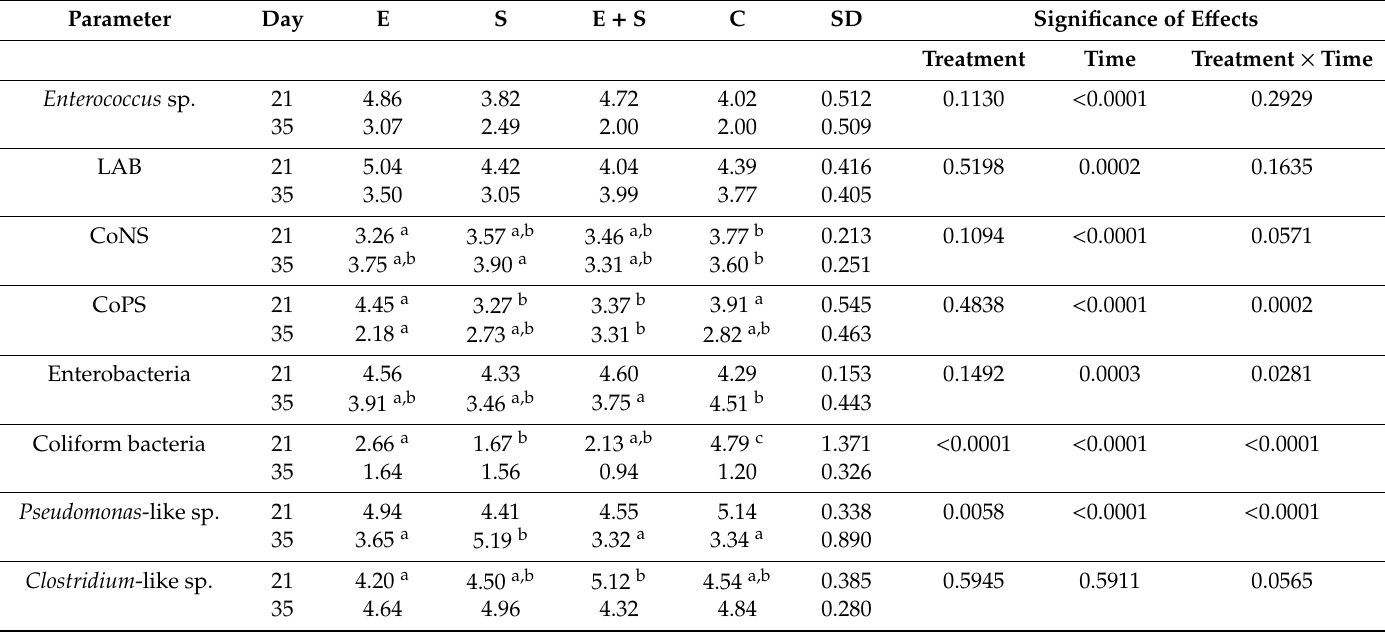
Treatment Time Treatment × Time